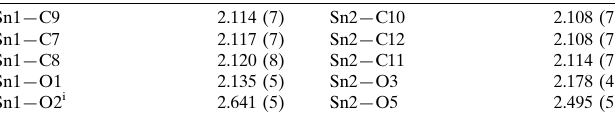
Selected bond lengths (A˚ ).